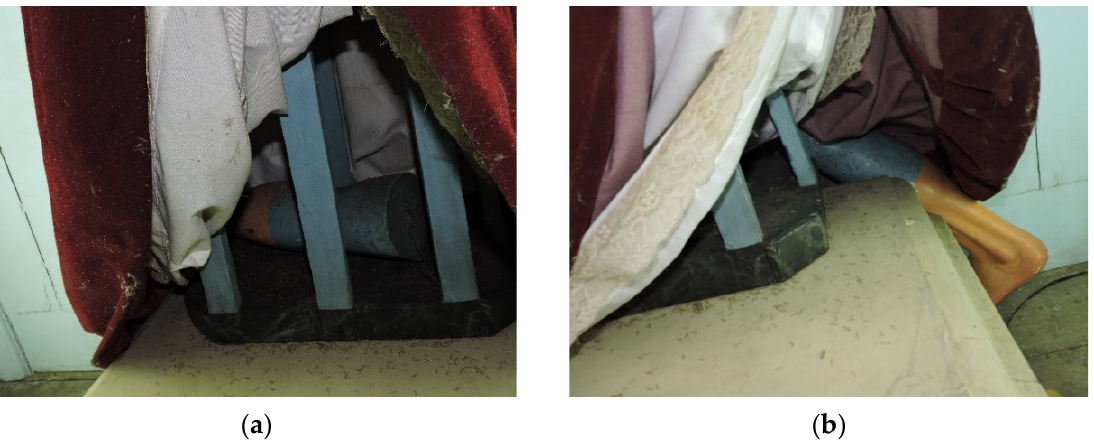
Figure 2. ( a ) Detail of the loose block of the right leg inside the slats. ( b ) Block of the left leg. Photos by Lia Brusadin, 28 December